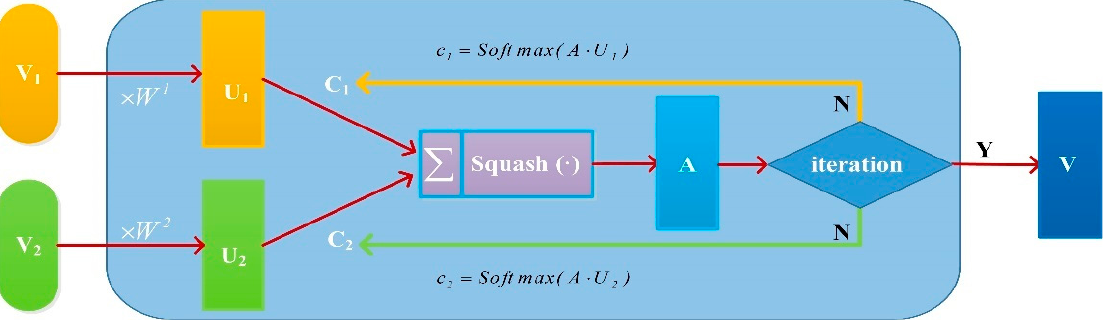
Figure 3. The flow of the dynamic routing algorithm.